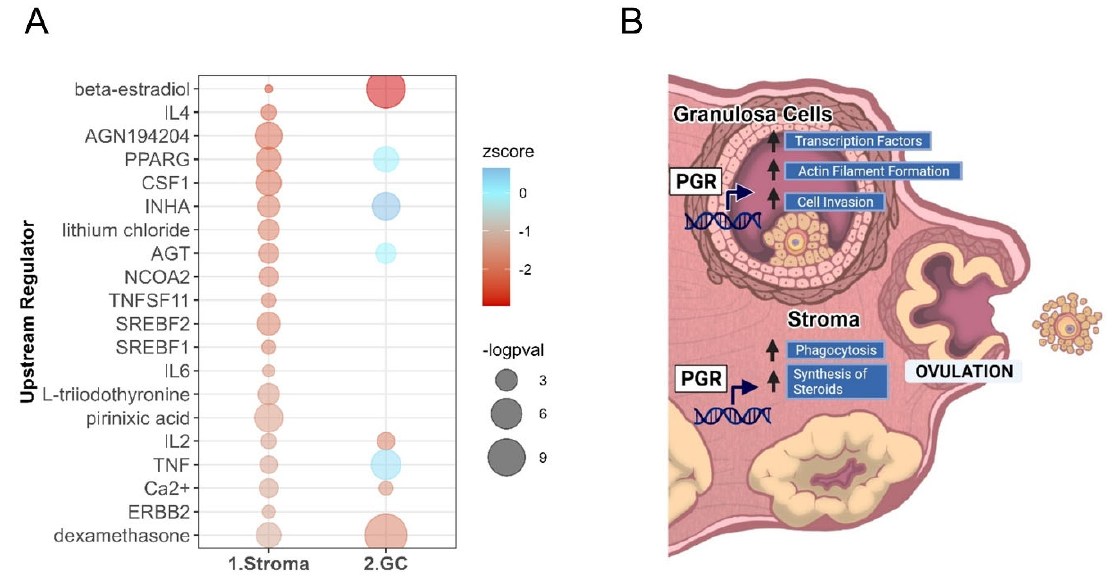
Figure 9. Pathways analysis comparing cell-specific DEGs shows unique regulation by PGR in stroma. ( A ) Top 20 deactivated upstream regulators predicted for stromal DEGs, ordered and colored by z-score indicating inactivation, sized by log p -val. The upstream regulators are also identified in the granulosa cell RNA-seq analysis shown on right. ( B ) Summary of the effect of PGR on intraovarian functional pathways at ovulation.